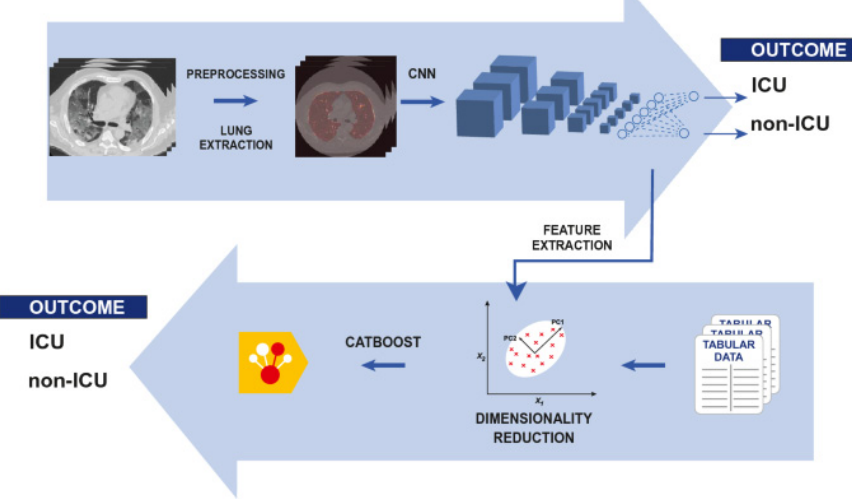
Figure 3. Severity and progression of COVID-19 virus reveal by AI through medical images and other clinical data [39]. CT and X-ray Medical Images for COVID-19 Diagnosis